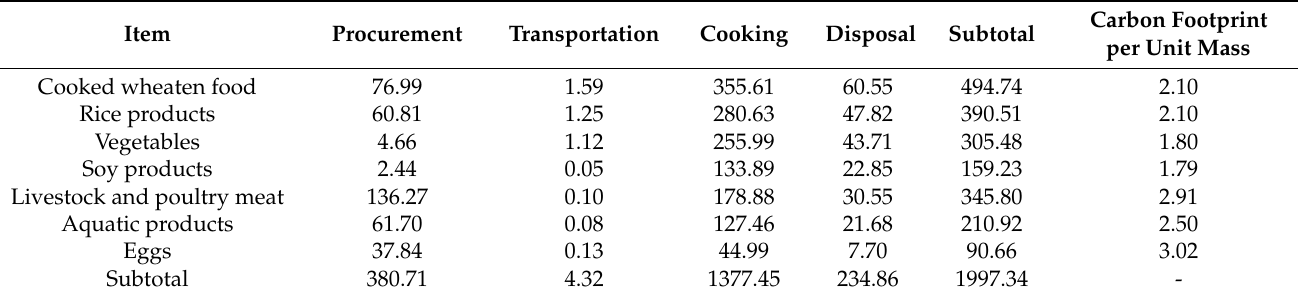
Table 5. Carbon footprint of food waste in university canteens (unit: kgCO 2